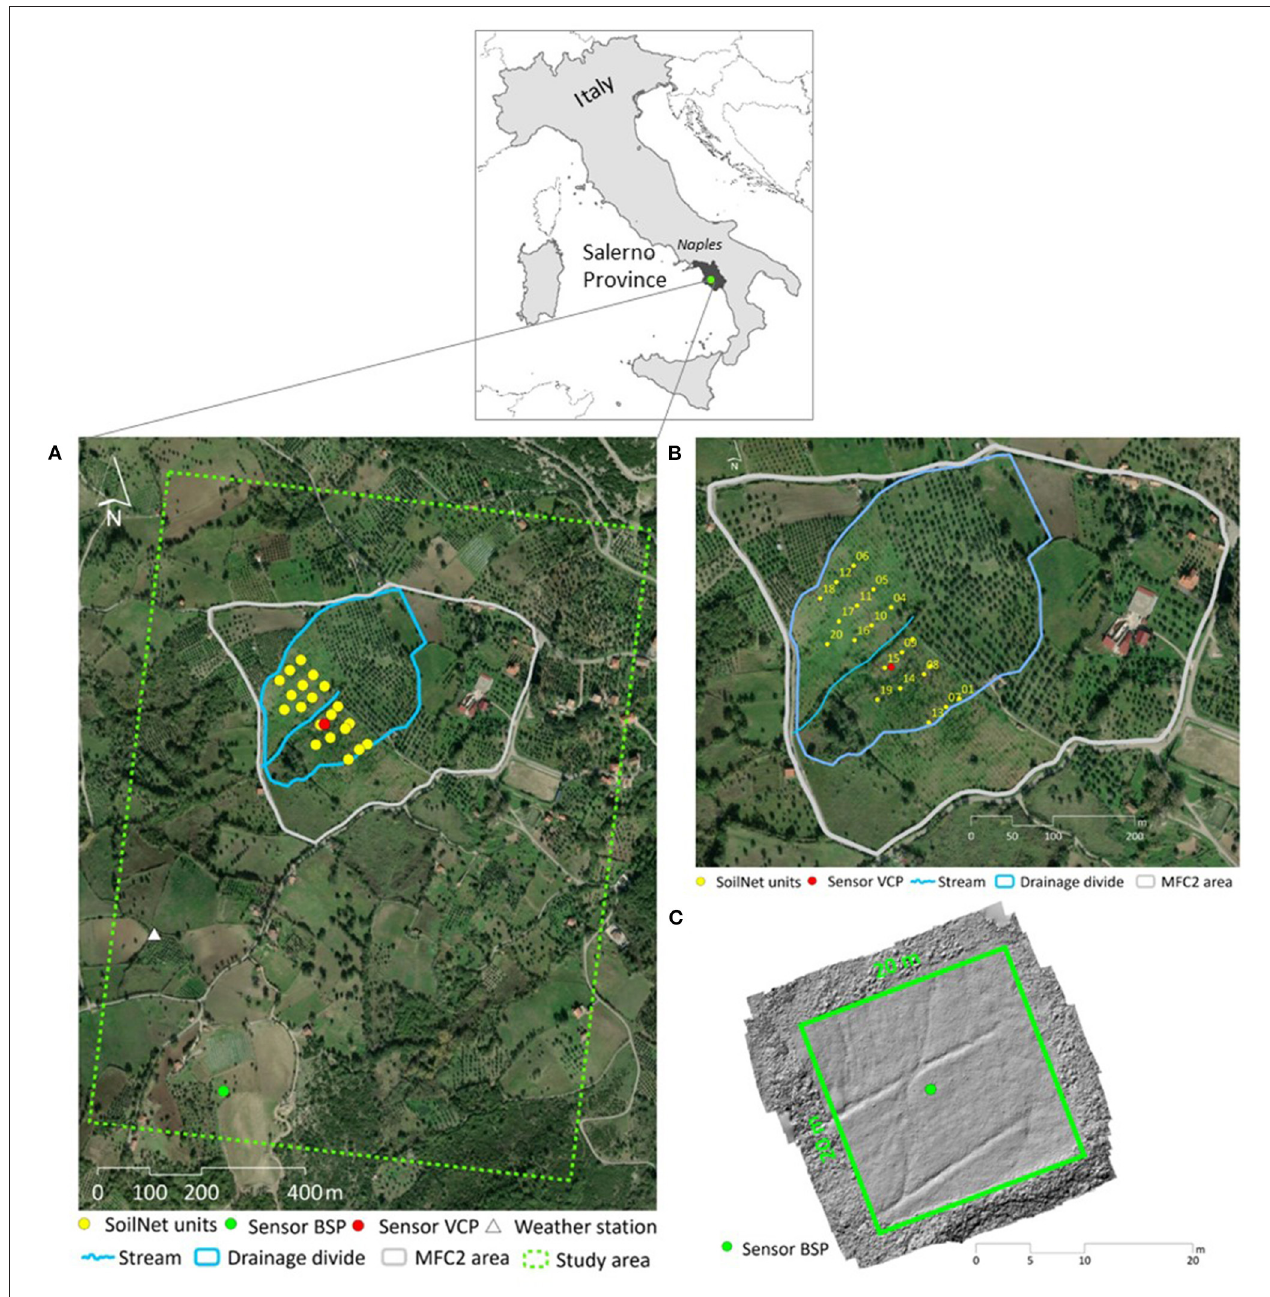
FIGURE 1 | Location of the study area in southern Italy and the soil moisture network. (A) The study area comprises the area of MFC2 with the hydrological divide and the 20 SoilNet units, and the stationary sensor locations VCP in MFC2 and BSP, and the weather station. (B) The area of MFC2 with 20 SoilNet units and the stationary sensor VCP. (C) The bare soil plot with the stationary sensor BSP in its